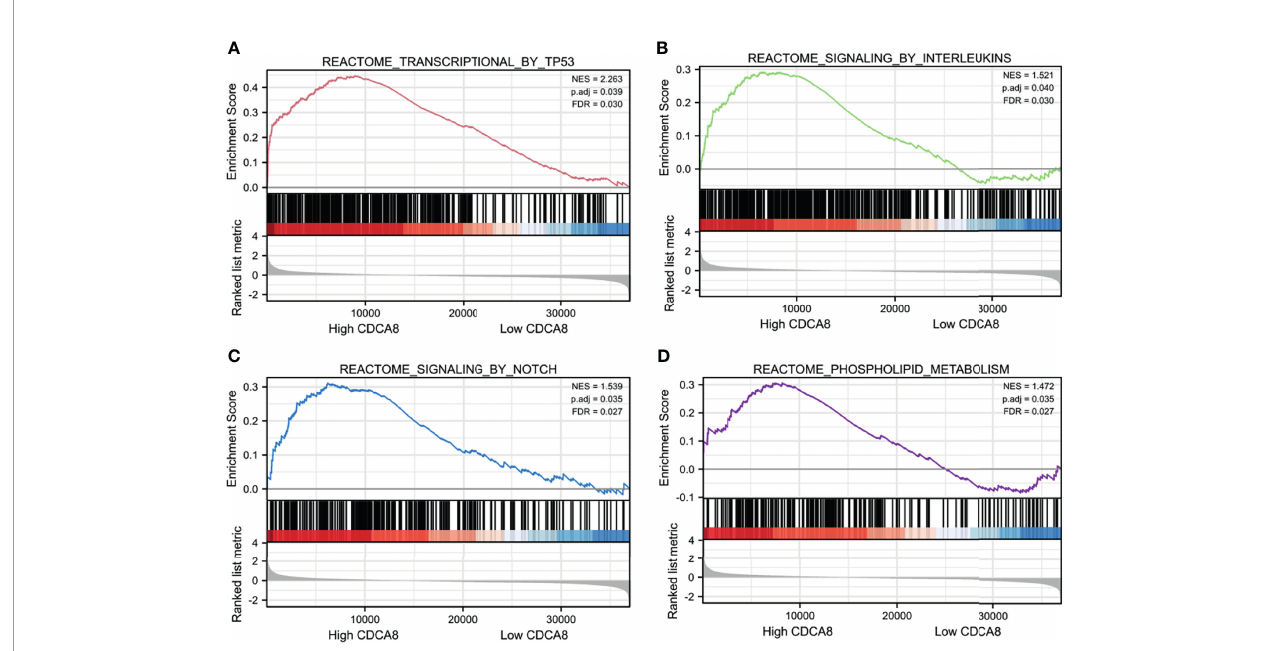
FIGURE 7 | GSEA analysis of CDCA8 co-expressed genes. High CDCA8 expression showed differential enrichment in TP53 (A) , interleukin (B) , NOTCH (C) , and metabolic function (D)